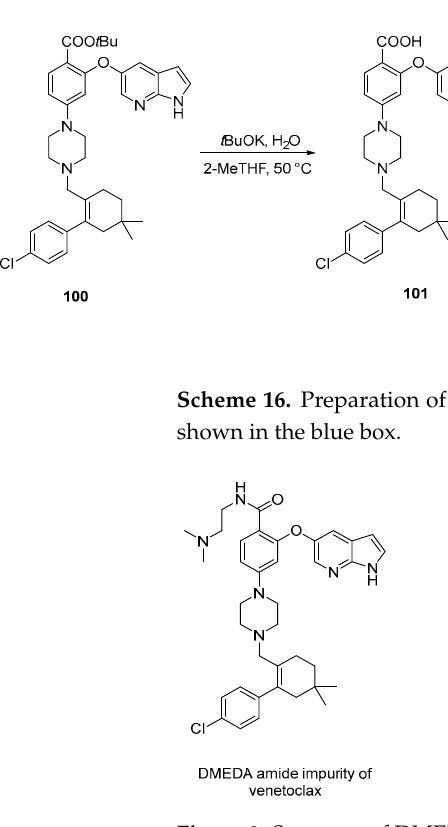
Figure 2. Structure of DMEDA amide impurity encountered in the synthesis of venetoclax ( 103